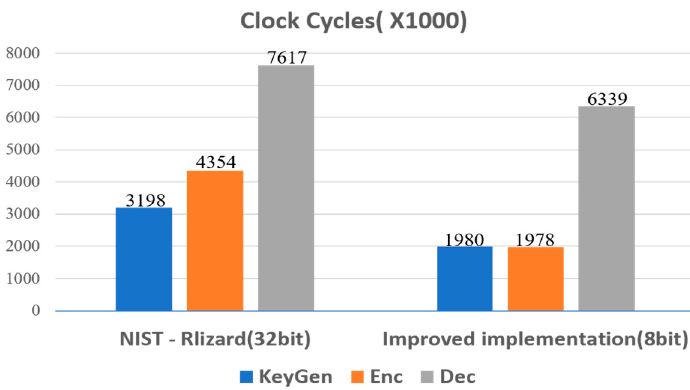
Figure 4. Comparing the required clock cycles: [7] and the proposed implementation.